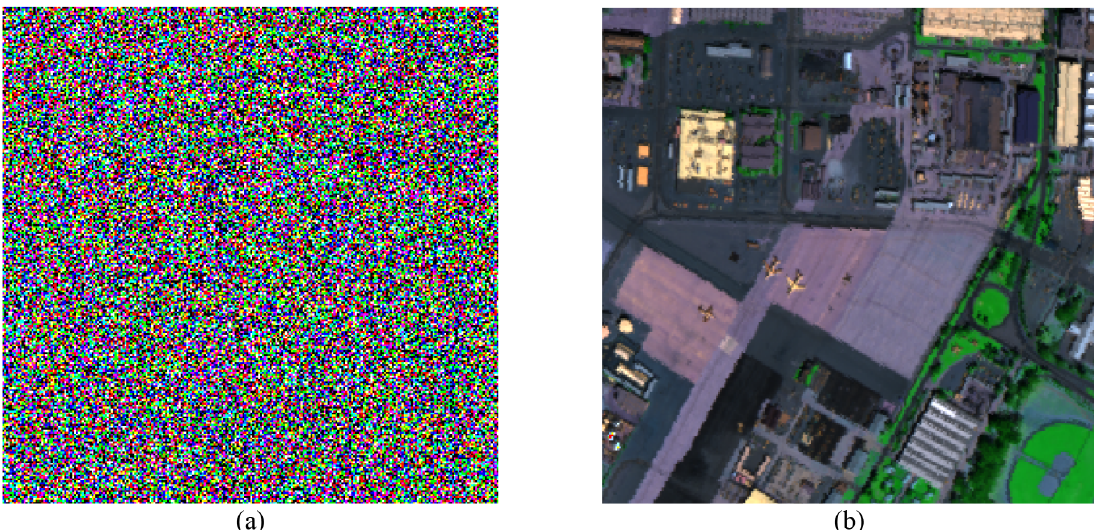
Figure 6. The experimental results: ( a ) the encrypted data of the pseudo color image and ( b ) the corresponding correct decrypted